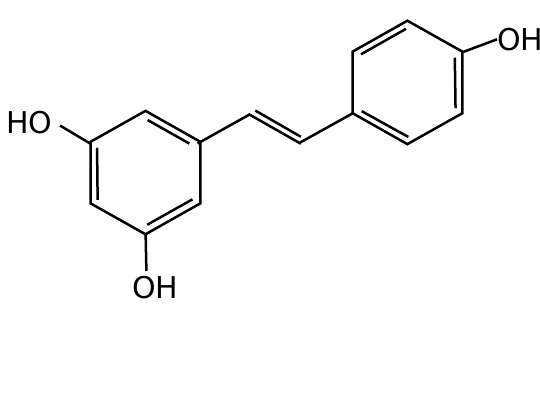
Figure 2. Chemical structure of